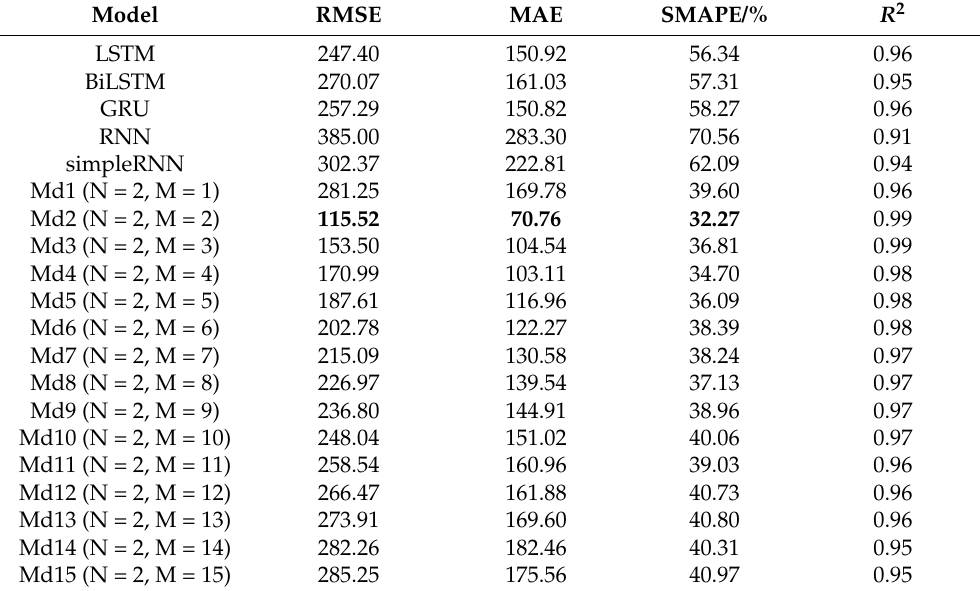
Table 3. Performance comparison between different